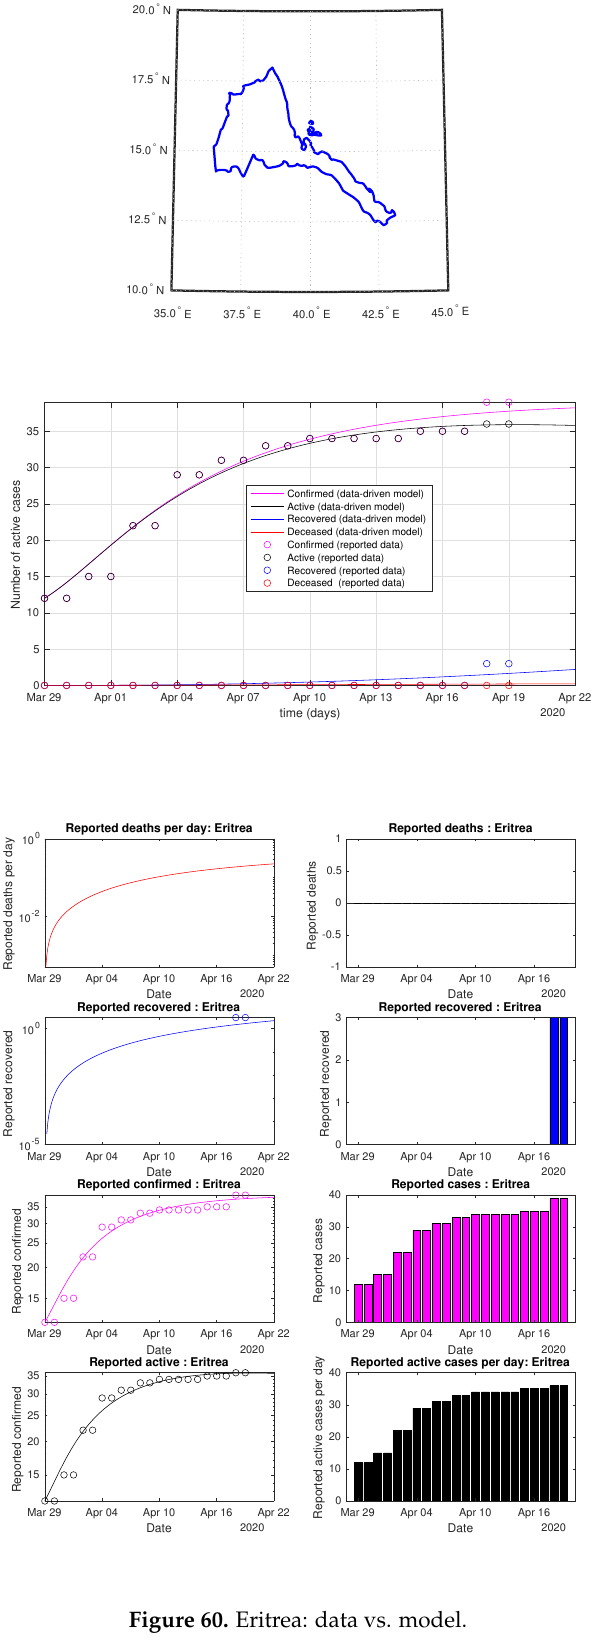
Figure 60. Eritrea: data vs.